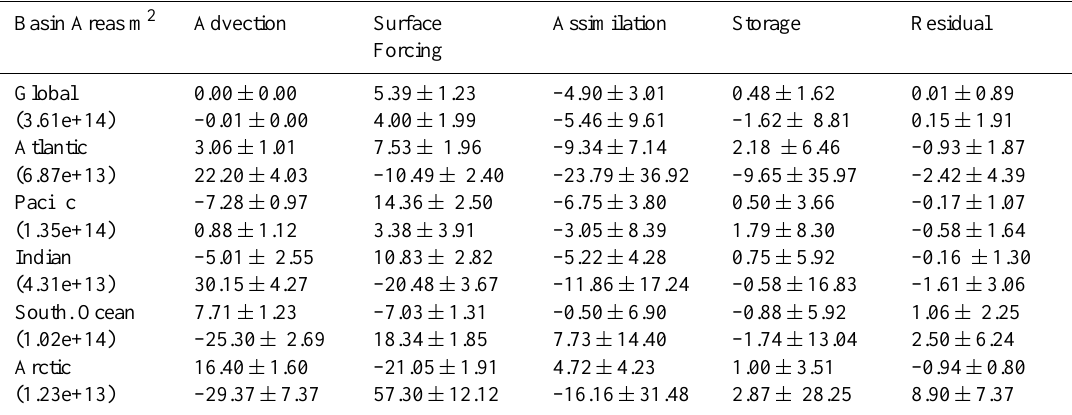
Fig. 2. Annual time series of the global ocean heat budget from 1993–2009. The terms are Qnet, the surface heat flux; Qassim, the equivalent heat flux coming from data assimilation increments vertically integrated; and Qt, the heat storage associated with changes in global mean temperature. Table 1. Vertically integrated heat and freshwater budget averaged over the period 1990–2009 for the global ocean and for individual oceanic basins (domains shown in Fig. 3). Upper numbers indicate heat fluxes in Wm − 2 ; lower numbers indicate freshwater fluxes in cmyr − 1 and errors represent annual standard deviations. The residual is computed as the sum of advection, surface forcing and assimilation minus the contribution from the storage. Positive values indicate fluxes into the